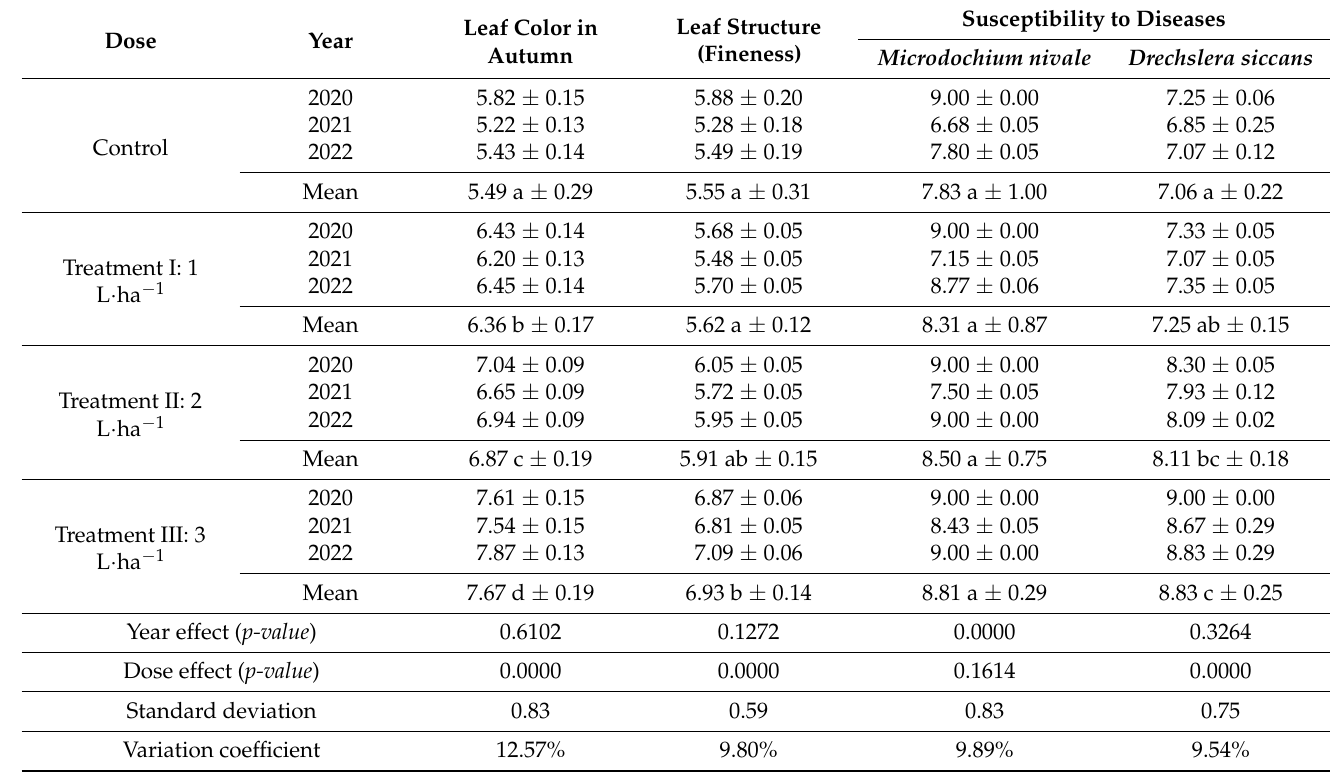
Table 6. Leaf color, leaf structure, and susceptibility to diseases depending on the year and dose of mineral-organic multi-component fertilizer application.